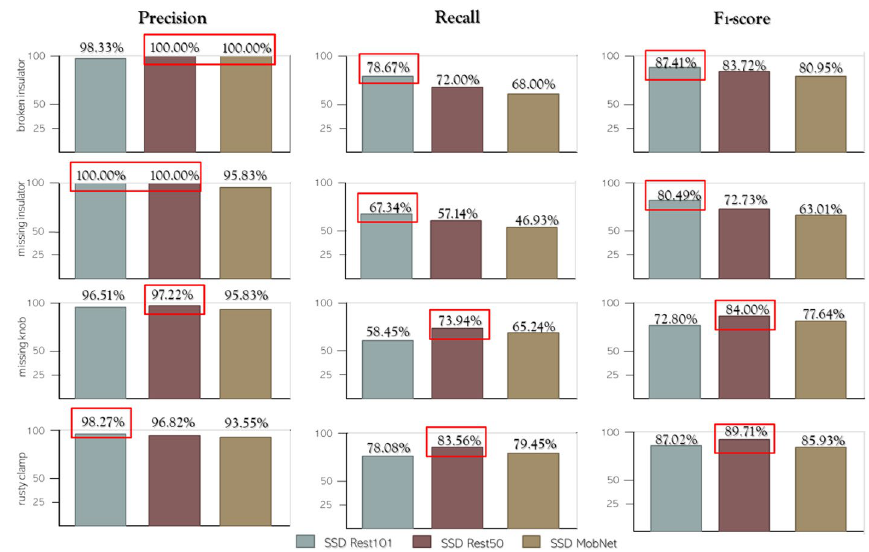
Fig. 11 A comparative view of the performance